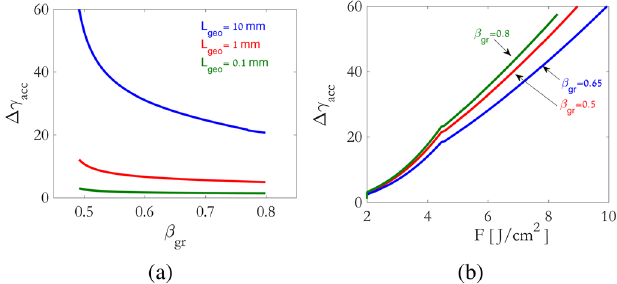
FIG. 5. Energy gain as a function of: (a) group velocity for the three fluence regimes, and (b) fluence for three values of group velocity. Although the energy gain is smaller for shorter struc- tures, it is independent of the group velocity. Also, while the energy gain is a square root of the fluence (Eq. (A1), self consistent analysis indicates virtually linear dependence for F > 4 . 4 J = cm 2